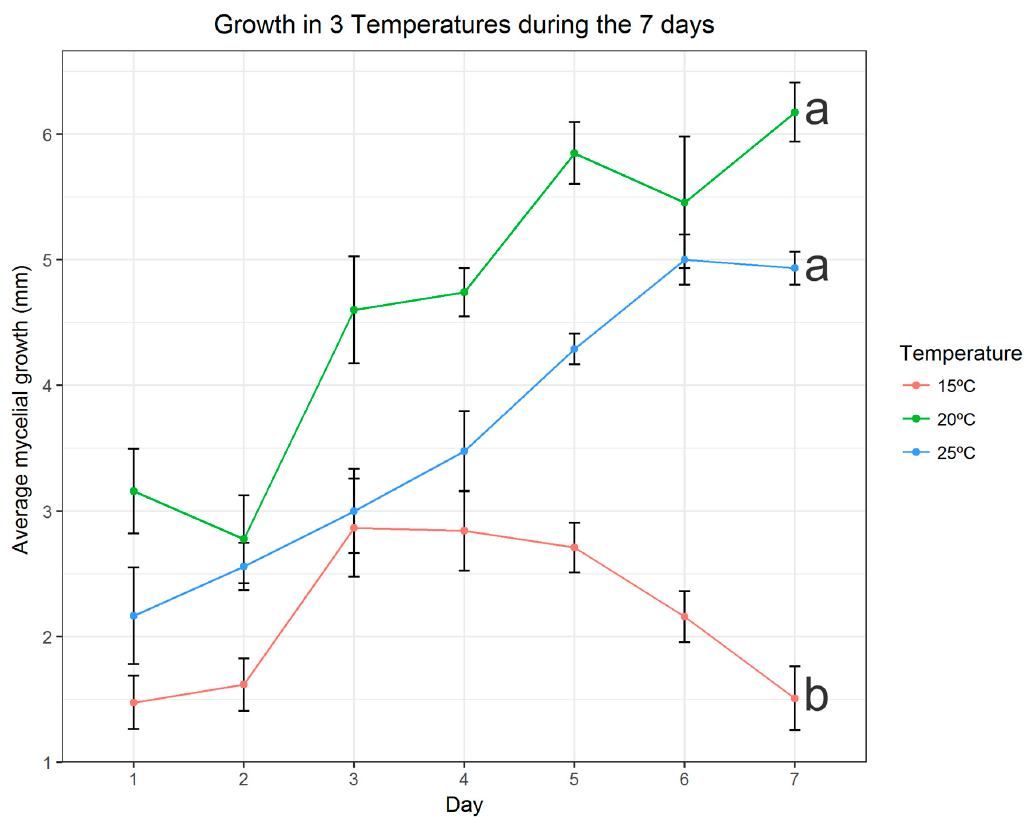
Figure 5. Average mycelial growth in mm during the 7 days of measurement at the 3 different temperatures. The graphic was built using specific packages in the R studio software. Temperatures followed by the same letter do not differ in the Tukey test at 5%.